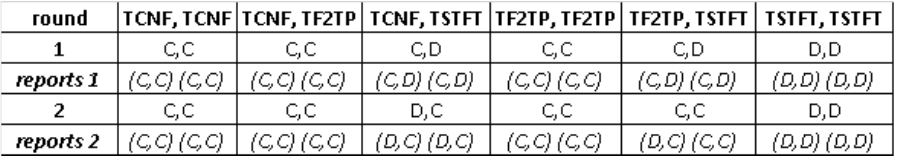
Patterns of interactions and reports in the first two rounds for every possible pair of strategies in an exemplary population consisting of CNFT, TF2TP and